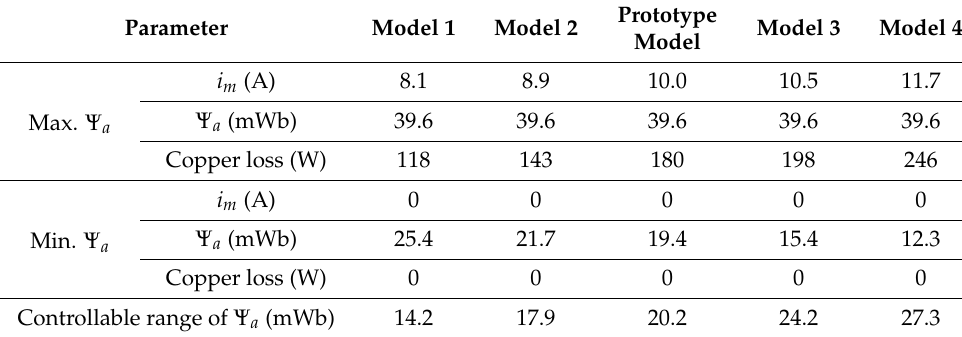
Figure 12. Magnetic fields of proposed motor models with different magnetic leakage path widths. Table 3. Magnetic field control performances of proposed motor models.